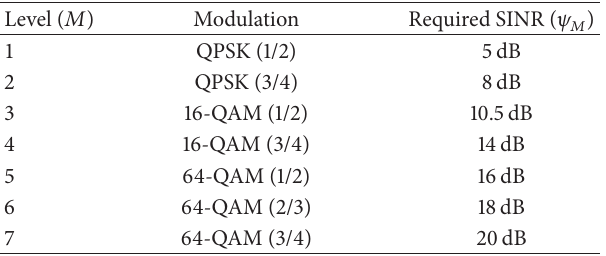
Table 3: Modulation and coding parameters